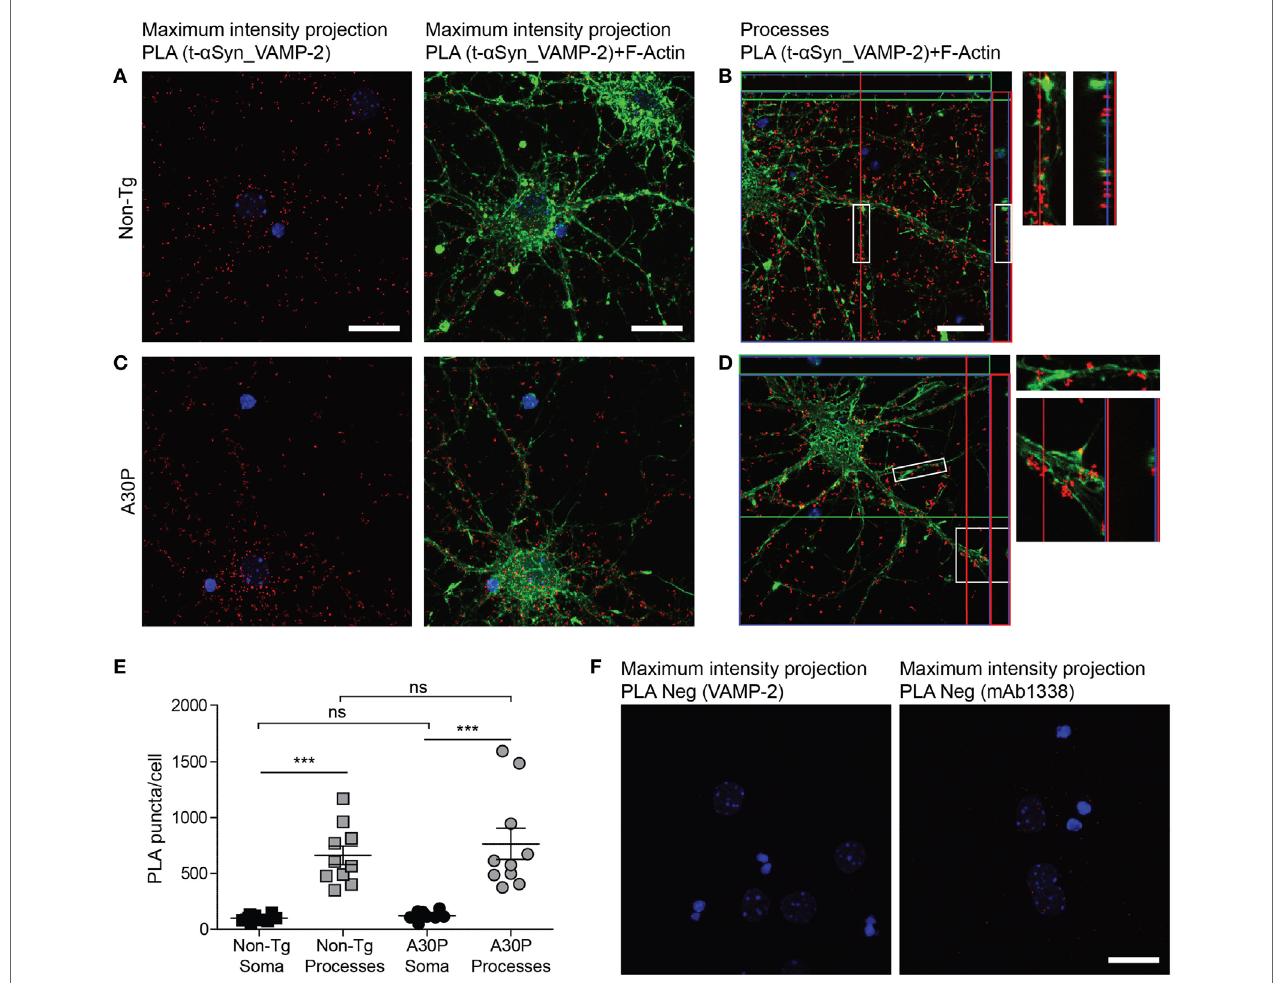
FigUre 3 | Representative confocal images of in situ proximity ligation assay (PLA) between alpha-synuclein ( α Syn) (mAb1338) and VAMP-2 (red) in non-tg (a,B) and A30P (c,D) cortical primary neurons. Maximum intensity projections of a confocal z-stack including a whole cell were performed to observe the maximum amount of PLA puncta (a,c) . Cross section of the processes allows visualization of the PLA puncta in an orthogonal view [ (B,D) , inlet], scale bar 20 µm. F-actin stained by phalloidin-FITC (green) and DAPI (blue). Quantification of amount of PLA puncta per cell in the soma and processes. One-way ANOVA followed by Bonferroni post hoc test, non-significant (ns), *** P < 0.001. Error bars represent the SEM (e) . Negative control PLA with VAMP-2 antibody only and α Syn antibody (mAb1338) only (F) . Scale bar 20